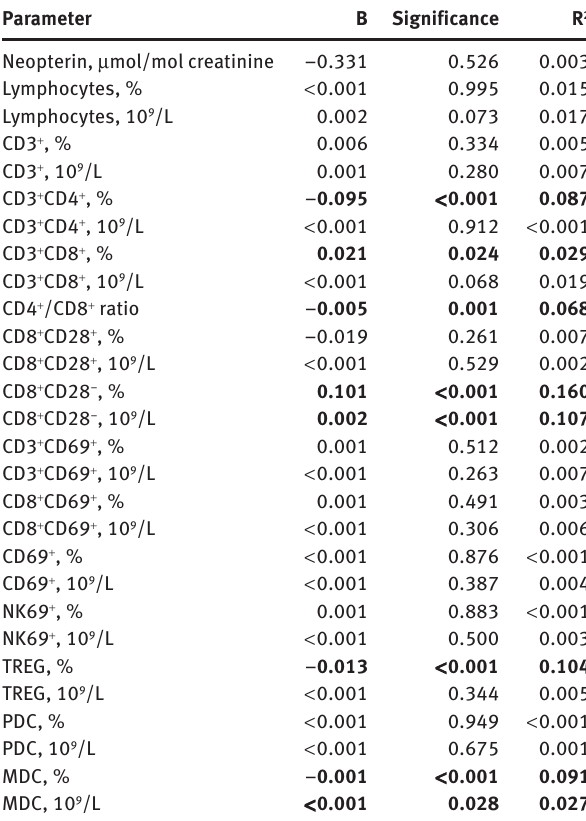
Table 2: Linear regression analysis of changes during the AC phase of primary chemotherapy (cohort A). Parameter